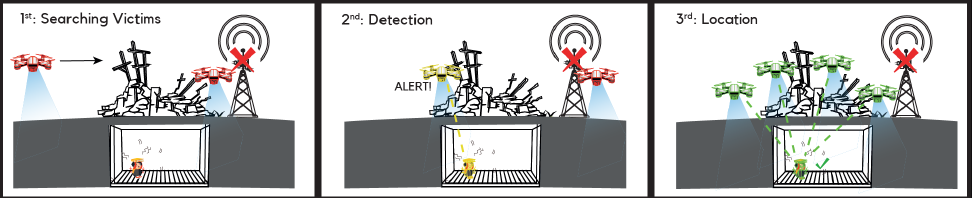
Figure 1. Illustration of the